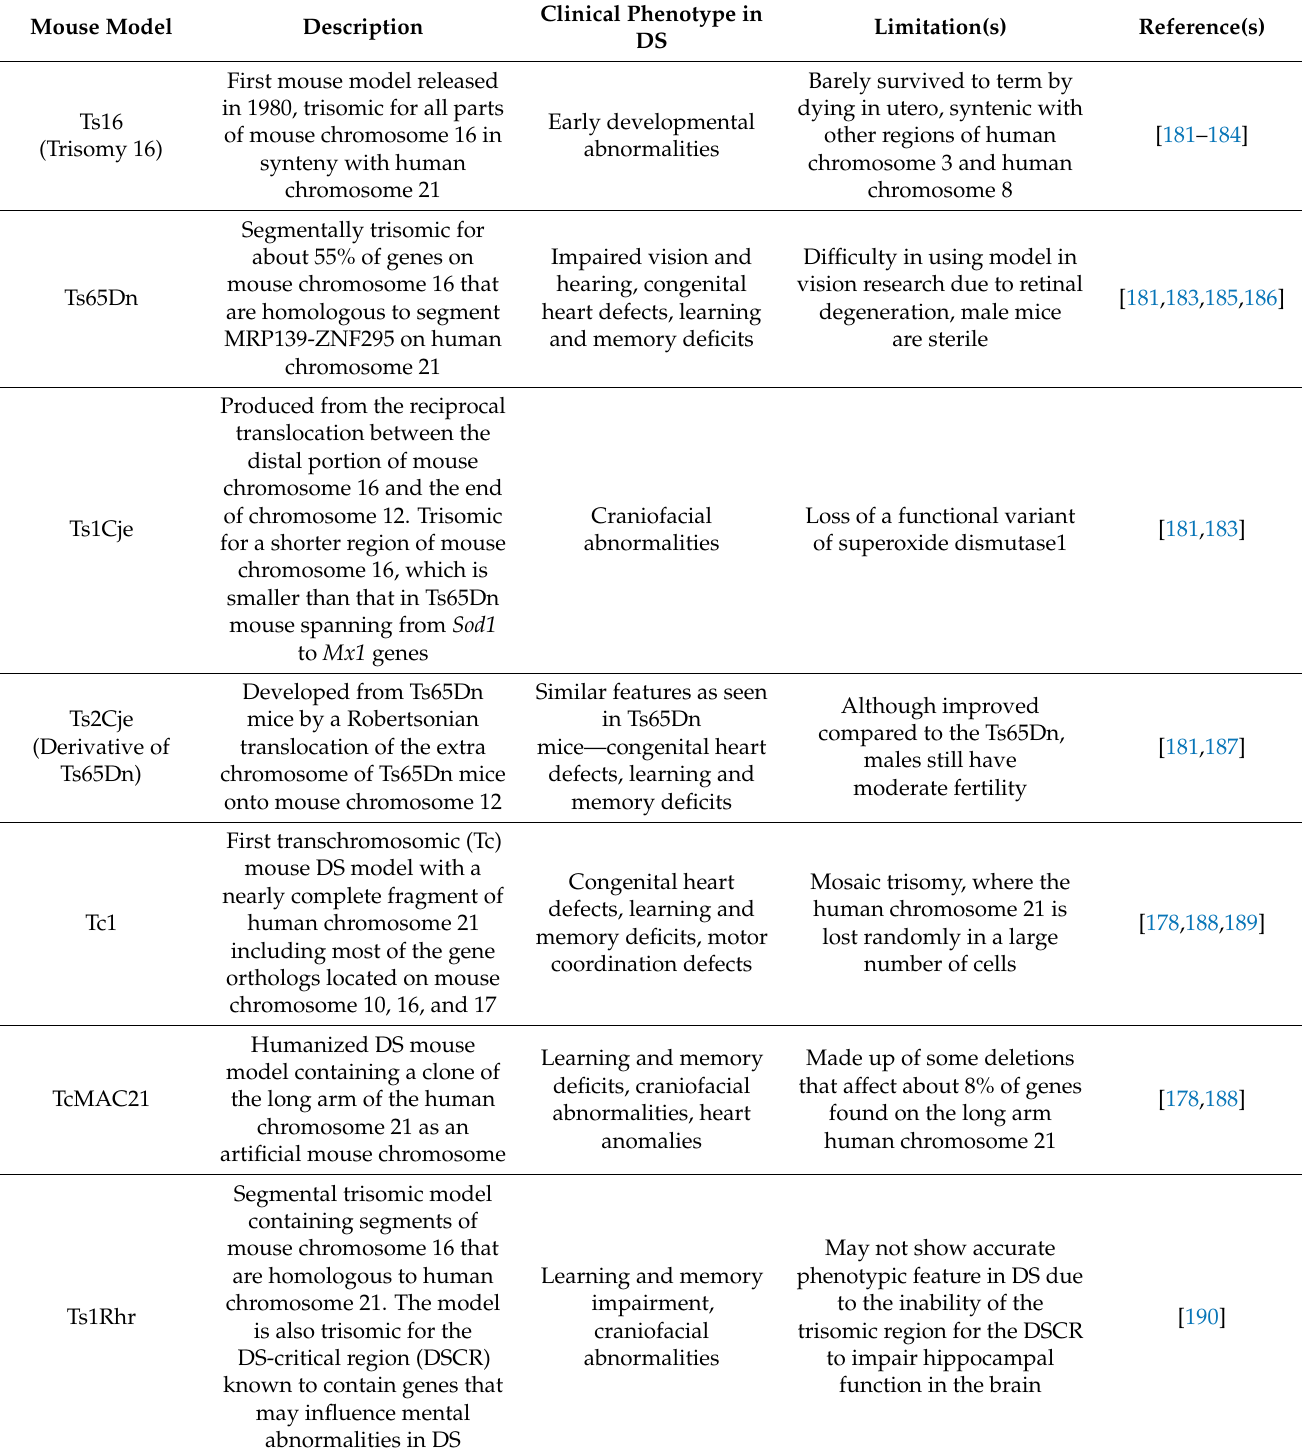
Table 3. Mouse models in